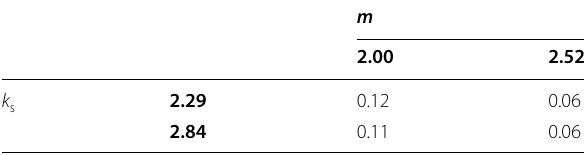
Table 1 The residuals between the estimated in situ porosity and the porosity estimated from the density log